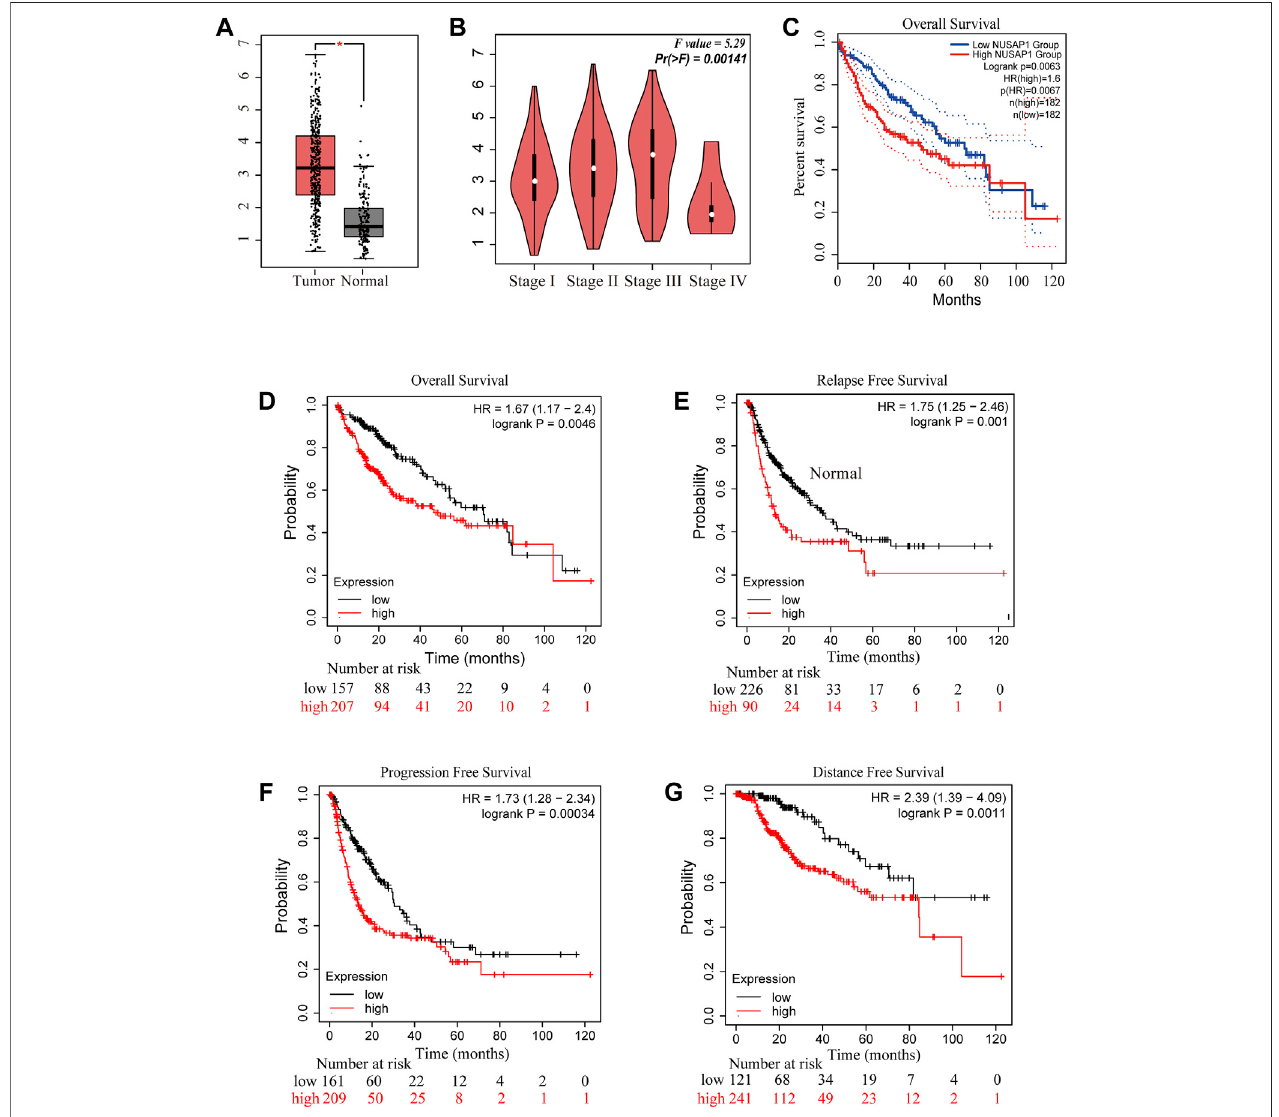
FIGURE 8 | NUSAP1 was highly expressed in HCC and correlated with poorer prognosis . (A) The expression of NUSAP1 in liver cancer (GEPIA) , (B) Correlation between the expression of NUSAP1 and tumor stage in liver cancer patients (GEPIA). Correlation between the expression of NUSAP1 and OS (C,D) , RFS (E) , PFS (F) and DFS (G) in liver cancer patients [ (C) from GEPIA: http://gepia.cancer-pku.cn/; (D – G) from KM plotter: http://kmplot.com/analysis/).